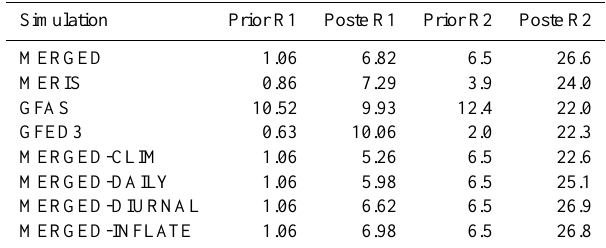
Table 1. Prior and Posterior Emissions. Emissions are given in TgCO and have been integrated from 16 July 2010 up to 17 August 2010. Region R1 is defined from 35 ◦ E to 45 ◦ E, and from 53 ◦ N to 58 ◦ N, see Fig. 3 and Konovalov et al. (2011). Region R2 is defined from 30 ◦ E to 70 ◦ E, and from 46 ◦ N to 70 ◦ N, see Fig. 3.